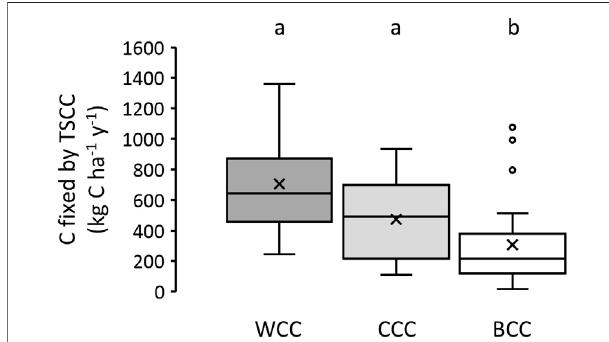
FIGURE 8 | Box and whiskers plot of phosphorus retention in TSCC for each of the cover crop layouts. Horizontal black line, x-shaped cross, box borders and whiskers stand for the median, the mean, quartiles and outliers. Different letters over the box-plot indicate signi fi cant differences ( p < 0.05).WCC,CCCandBCCstandforolivesgroveswhereTSCCoccupiedthe wholearea,wasabsentundertreecanopyoronlyoccupiedastripoftheinter- row area, respectively.